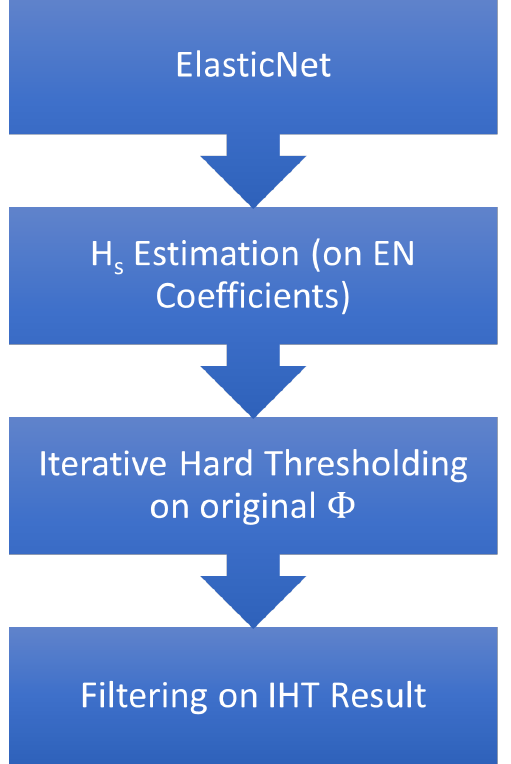
Figure 11. Novel processing chain for ground truth estimation in sparse SAR